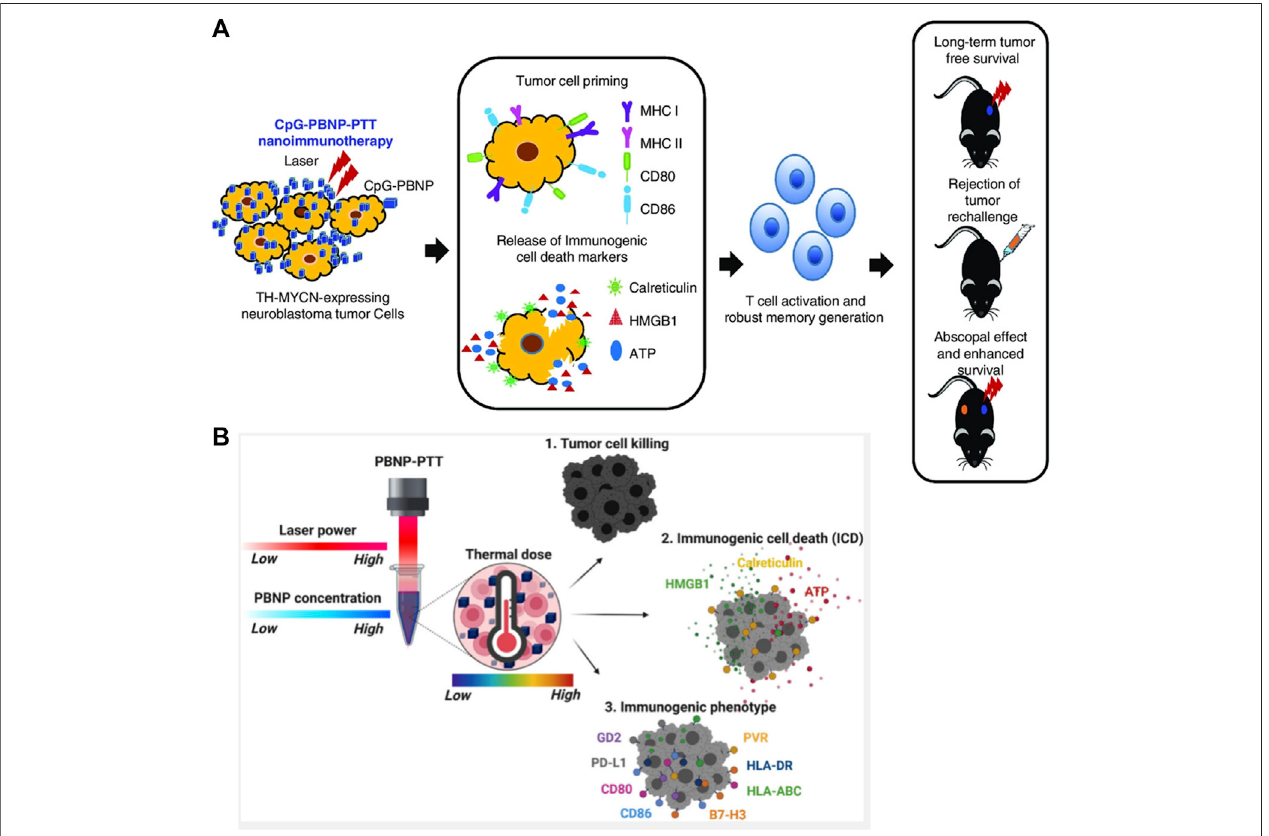
FIGURE 6 | Nanotechnology for immunotherapy in NB. (A) Schematic of the mechanism of action of the CpG-PBNP-PTT-based nanoimmunotherapy in the TH- MYCN model of NB. Reproduced with permission from (Shukla et al., 2021). Copyright 2021, Wiley-VCH Verlag GmbH & Co. KGaA, Weinheim. (B) Diagram of the induction of NB cell death and immunogenic cell death (ICD) by combined PBNP-PTT therapy. Reproduced from (Sekhri et al., 2022).